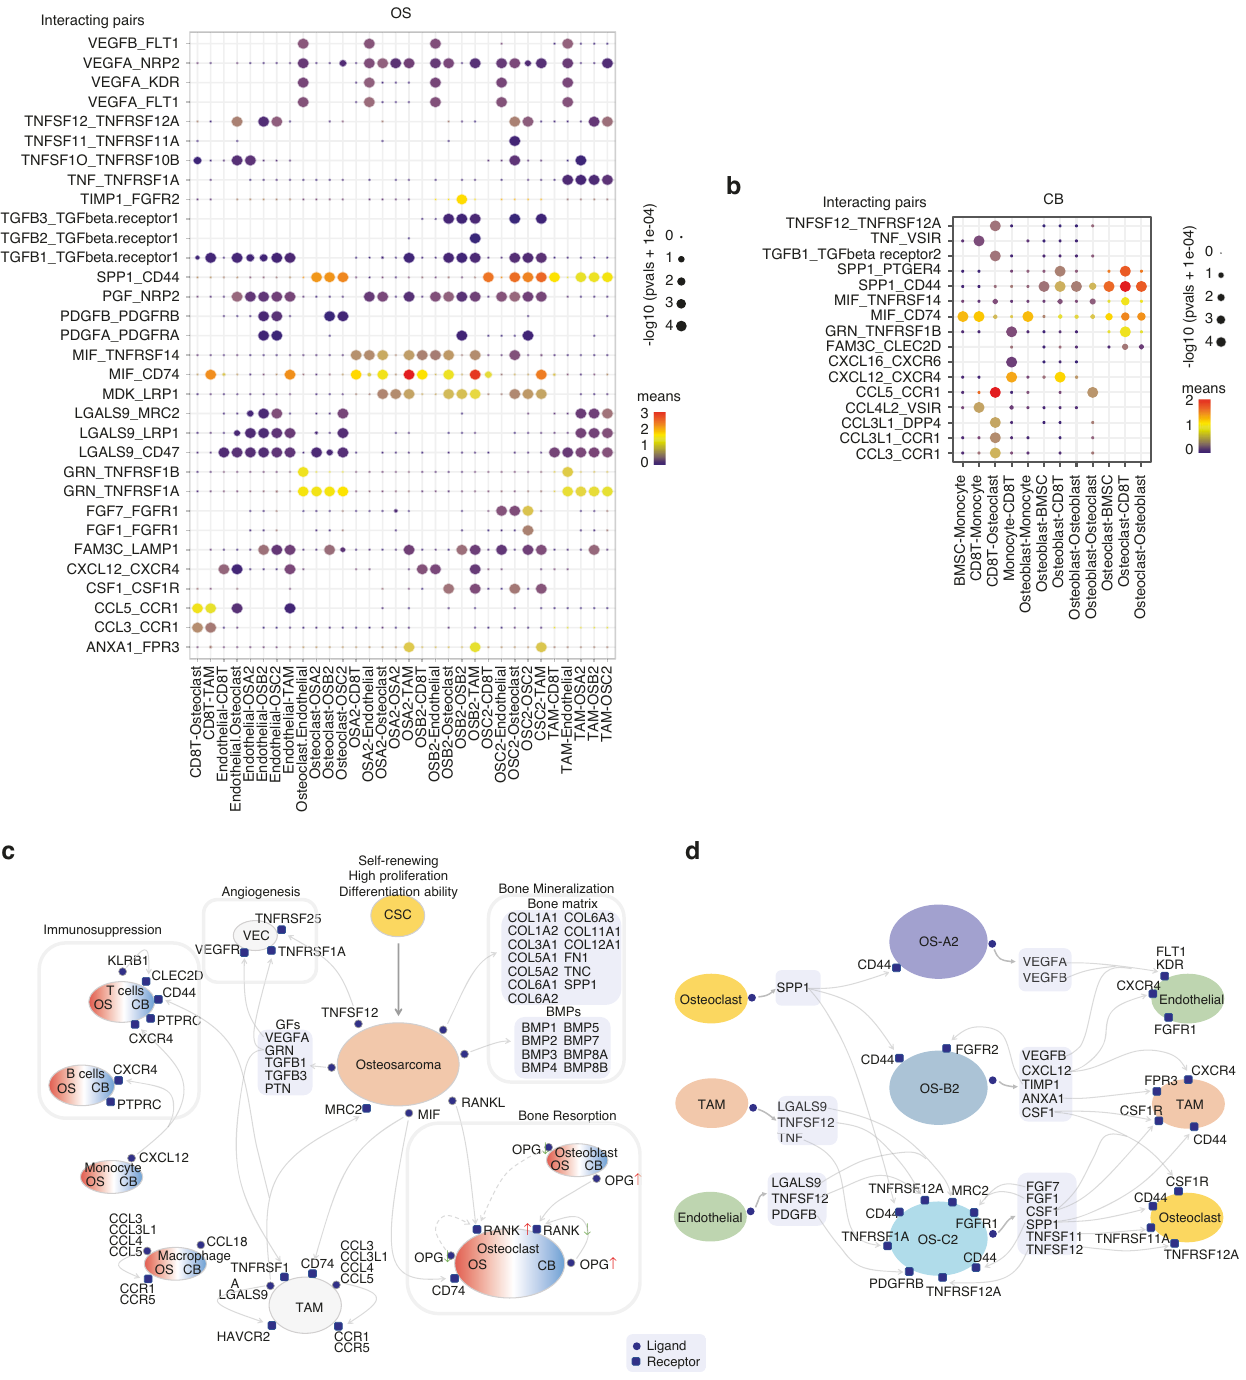
Fig. 8 Ligand-receptor interactions between clusters in OS and CB samples. a Dot-plot heatmap shows part of the ligand-receptor interactions between the clusters calculated by the CellPhoneDB method. b Dot-plot heatmap showing part of the ligand-receptor interactions between clusters in CB samples. c Schematic representation of differences in the microenvironment between OS and CB samples. d Schematic representation of differences in intercellular interactions between OS-A2/B2/C2 and other cell clusters in OS